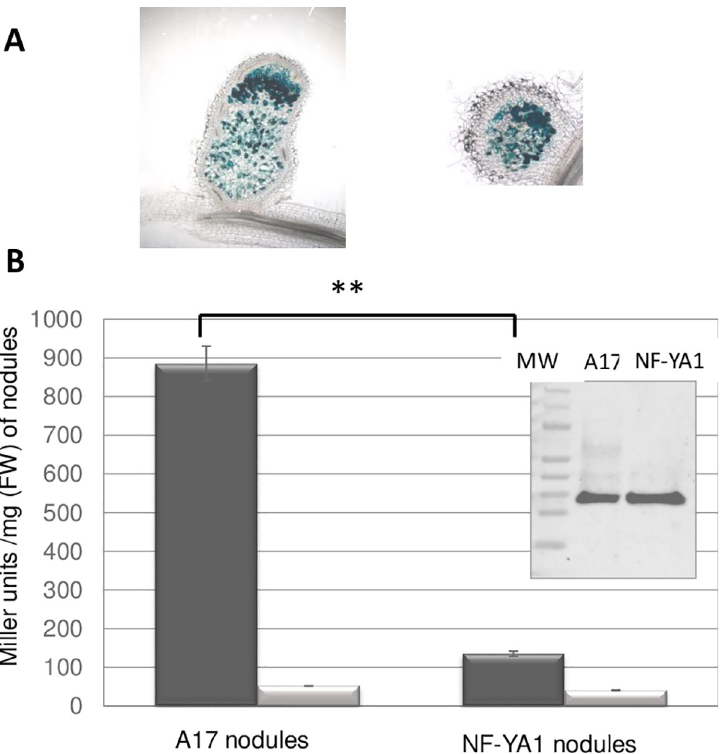
Fig 7. A Medicago truncatula Mtnf-ya1 null mutant nodules lack signal 1. Panel A: A17 (left) and Mtnf-ya1 (right) nodule sections colonized by a S . meliloti wt strain expressing a constitutive hemA-lacZ fusion. Endosymbiotic bacteria show a blue coloration. Panel B: signal activity of 25mg (FW) of wt (A17) nodules and Mtnf-ya1 nodules. Reporter strains are GMI12052 (wt, black) or GMI12071 ( cyaK ,(grey). Plants were grown under aeroponic conditions. P-value 0.0020, t-test, n = 3. The insert shows a Western blot of M . truncatula A17 and Mtnf-ya1 nodules with a human anti- RPL8 (RPuL2) antibody.